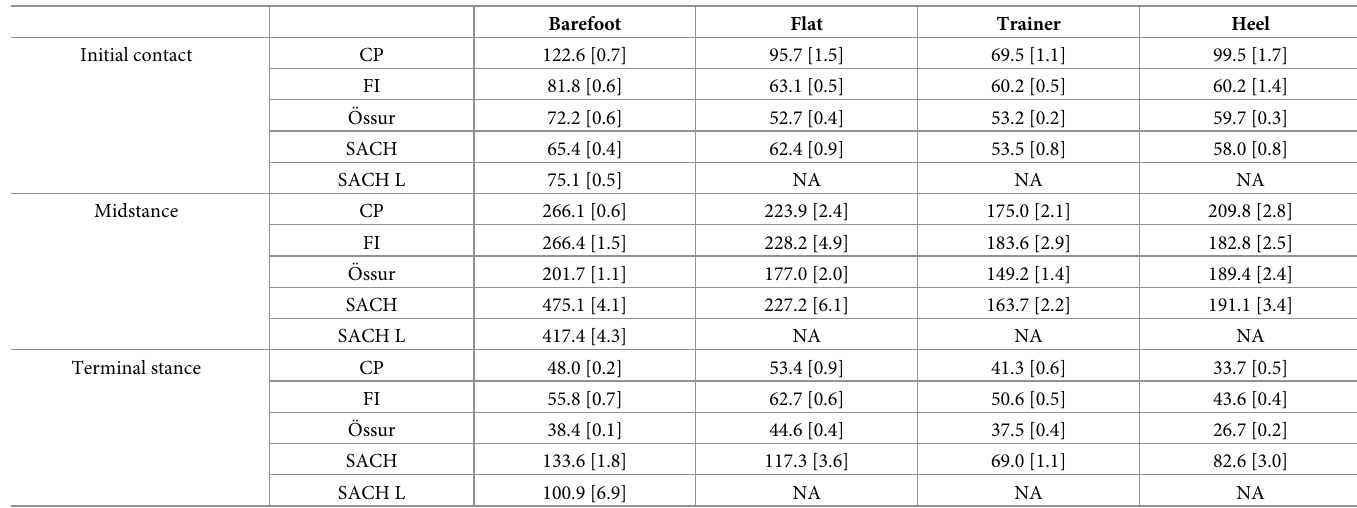
Table 3. Stiffness (N/mm; mean [95% confidence